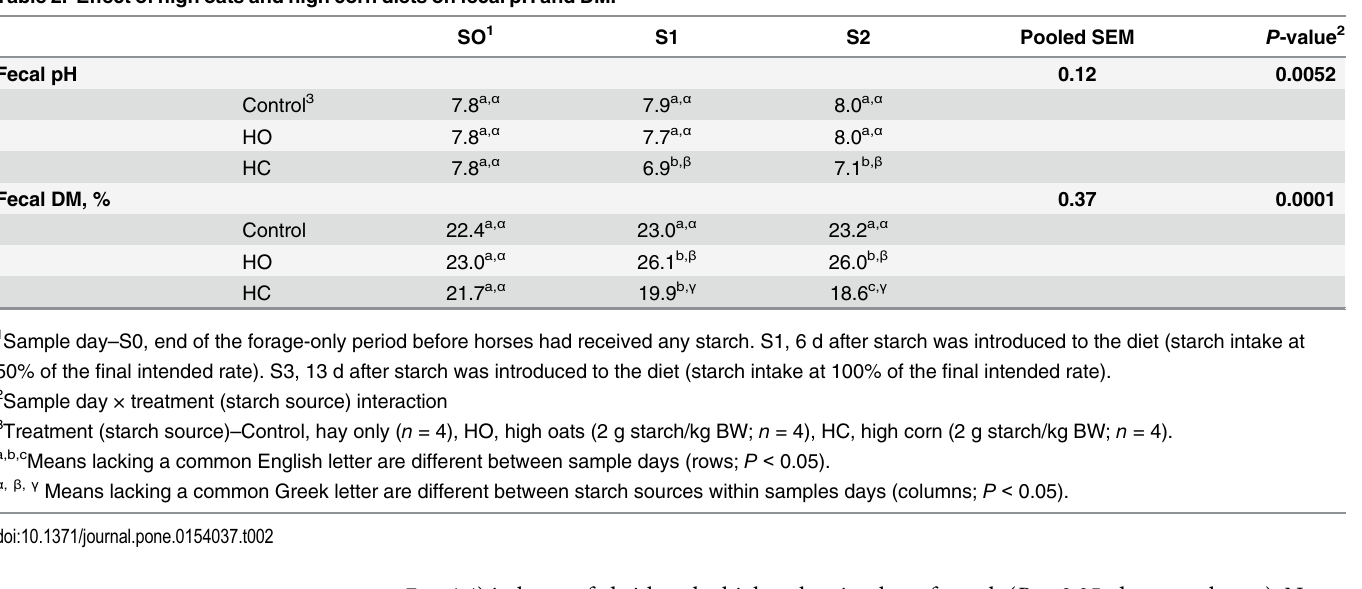
lactate was detected in any fecal sample over the course of the study.